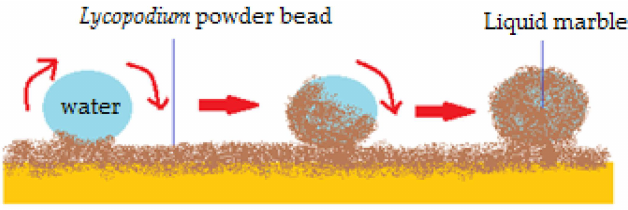
Figure 1. Obtaining liquid marbles by rolling water drops into a Lycopodium powder